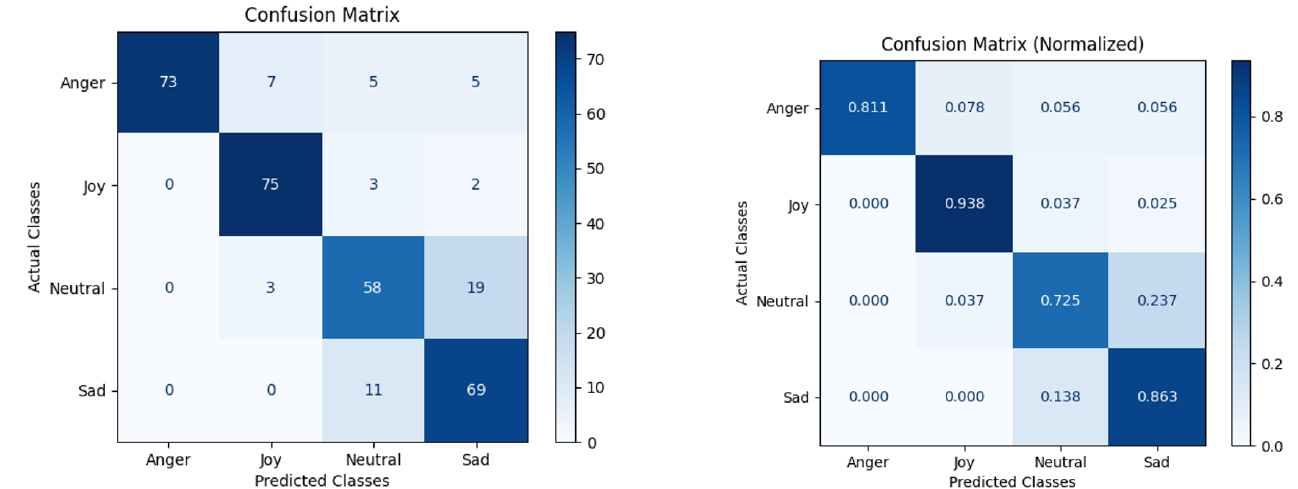
Figure 3. Confusion matrix of subjective evaluation of emotions in acting children’s speech in the Russian language by Russian experts on the extended dataset. Table 7. Overall scores in multi-class classification, extended expert’s feature set with 33 samples in total.